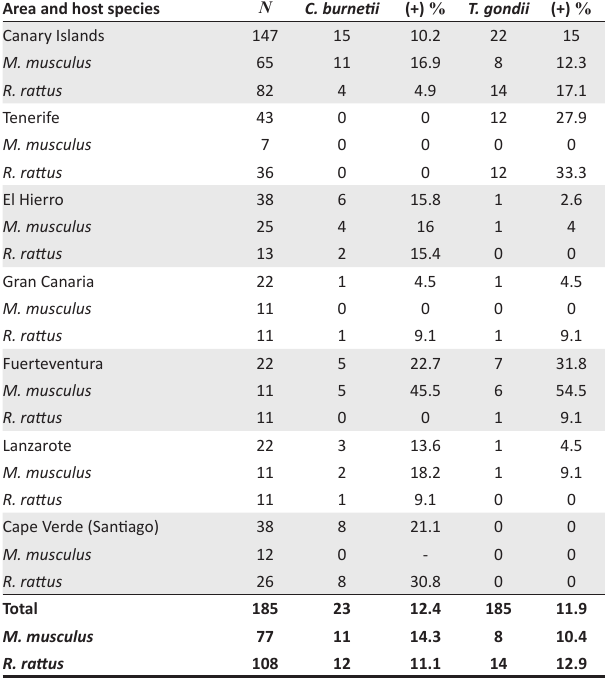
TABLE 1: Seroprevalence of antibodies against Coxiella burnetii and Toxoplasma gondii in rodents in the Canary Islands and Cape